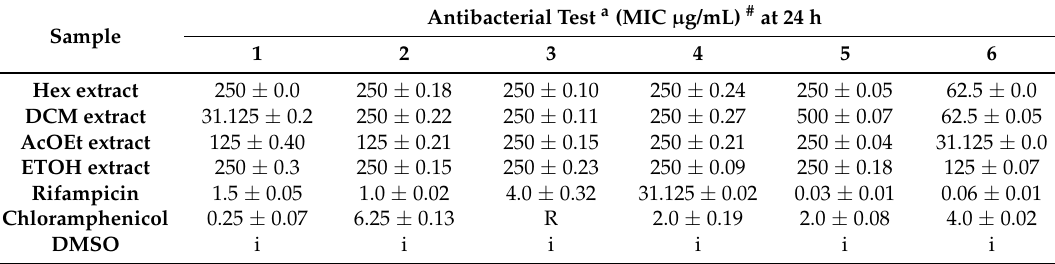
Table 2. Minimum inhibitory concentration of extracts from E. coccineum .